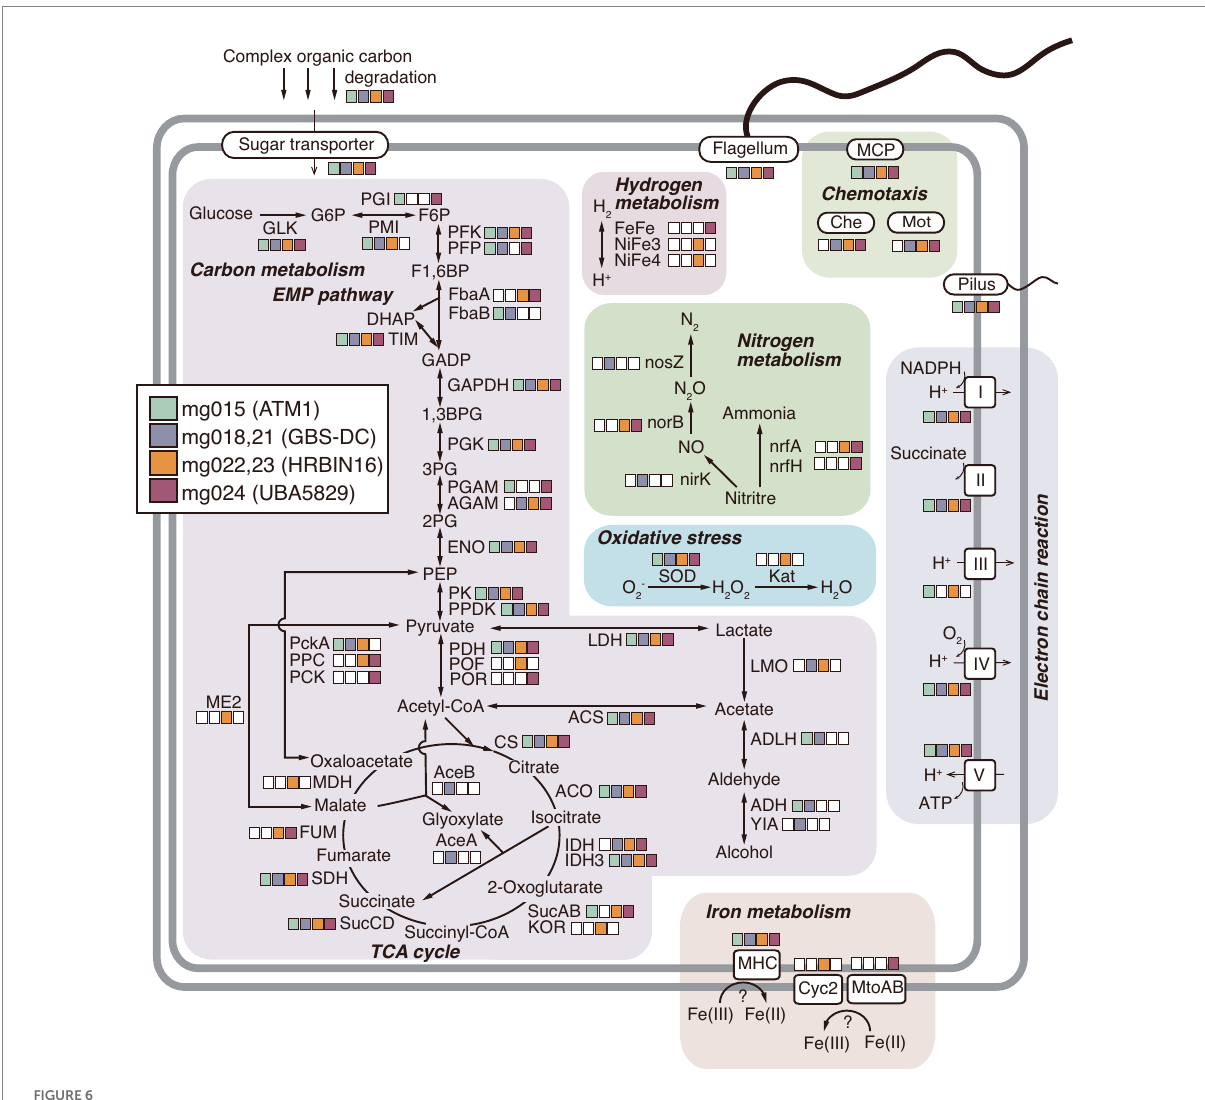
FIGURE 6 Metabolic potential for Armatimonadota members deduced from the HQ MAGs. Details of genes in the pathways are listed in Supplementary Table S7, in addition to Supplementary Tables S5,